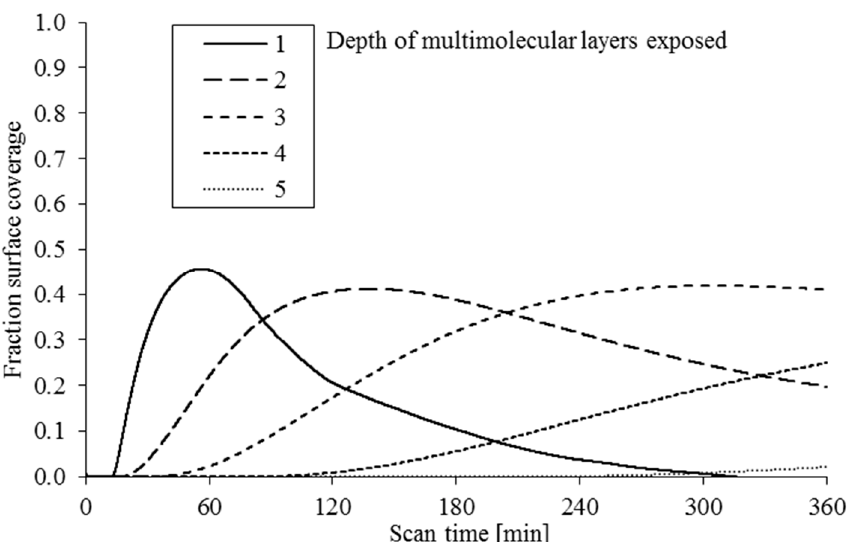
Figure 8. The predicted fraction of the surface coverage of multi-molecular layers within the test period.